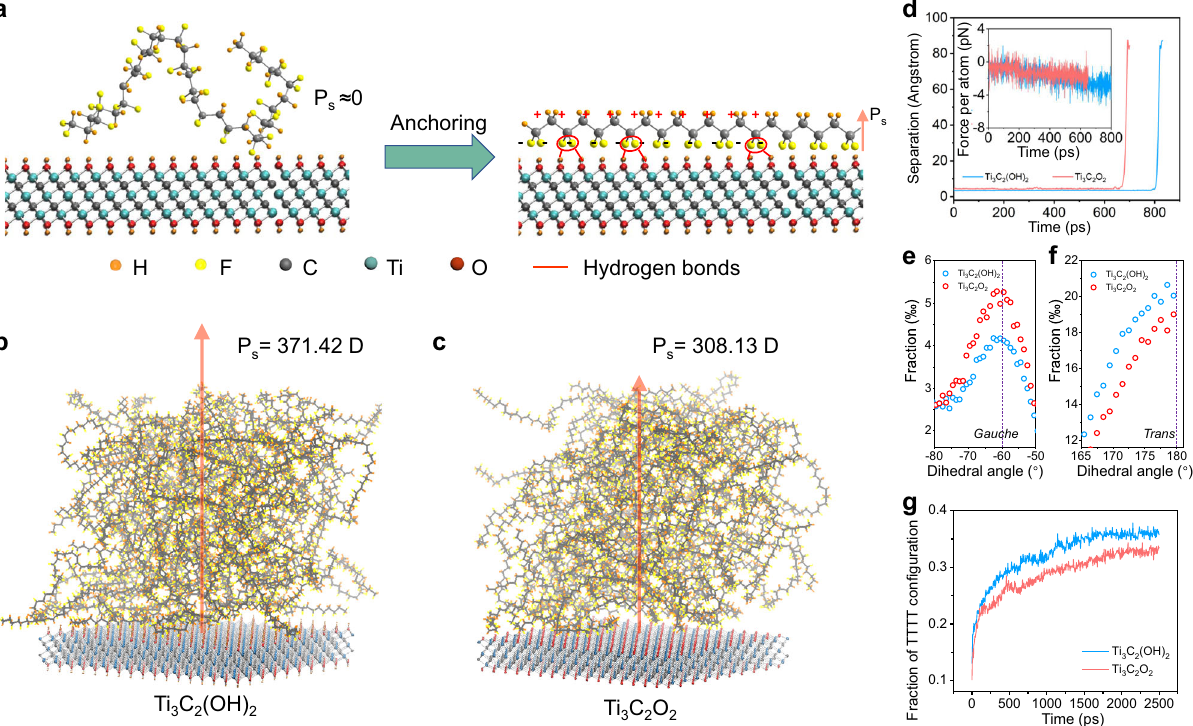
Fig. 1 | Hydrogen bonds induced anchoring effect enabled by MXene nanosh- eets. a Schematic of in-situ stretching and alignment of PVDF polymer chain via surface terminations on Ti 3 C 2 T x nanosheets to upgrade the spontaneous polar- ization (P s ). b , c Final snapshots for molecular dynamics (MD) simulations of the polarization of PVDF polymer fi lm on the Ti 3 C 2 (OH) 2 fl akes ( b ) and Ti 3 C 2 O 2 fl akes